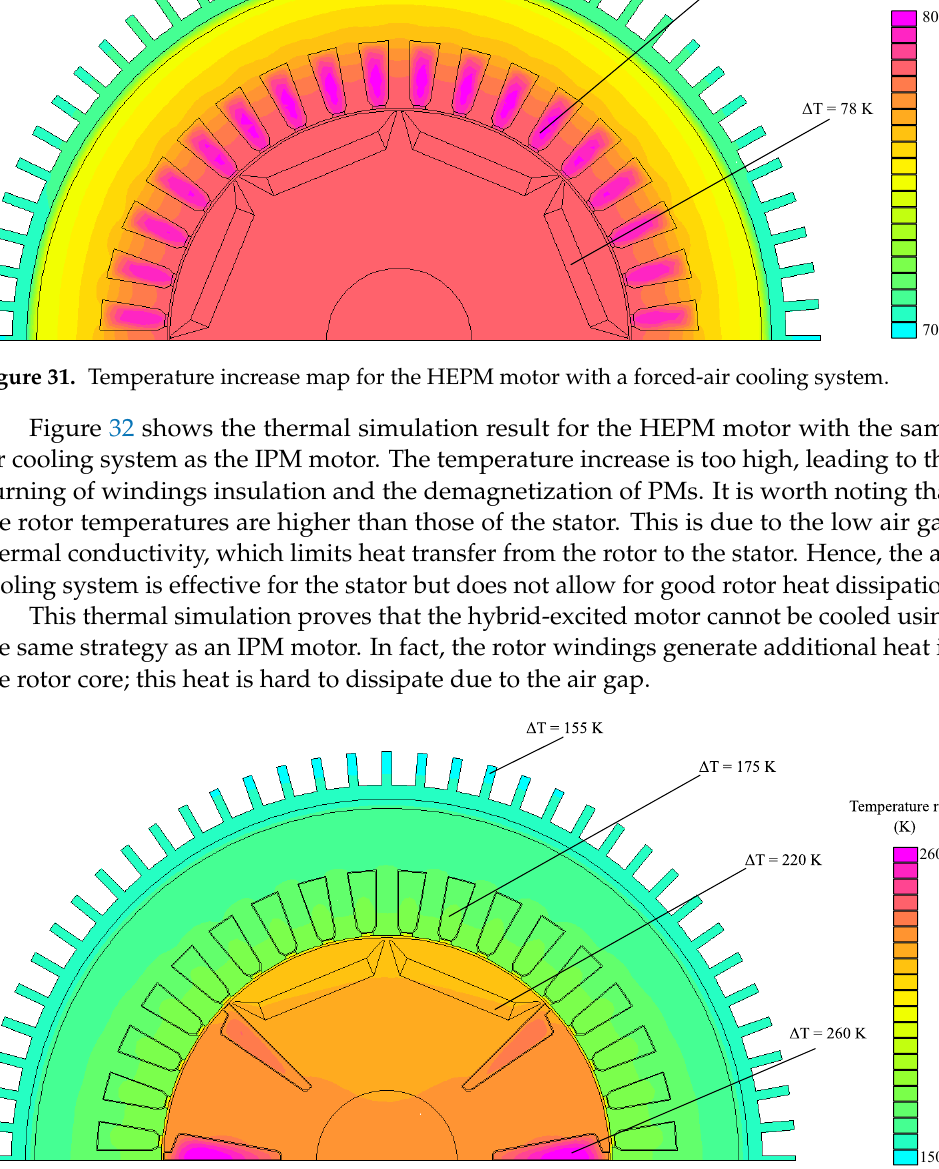
Figure 32. Temperature increase map for the HEPM motor with a forced-air cooling